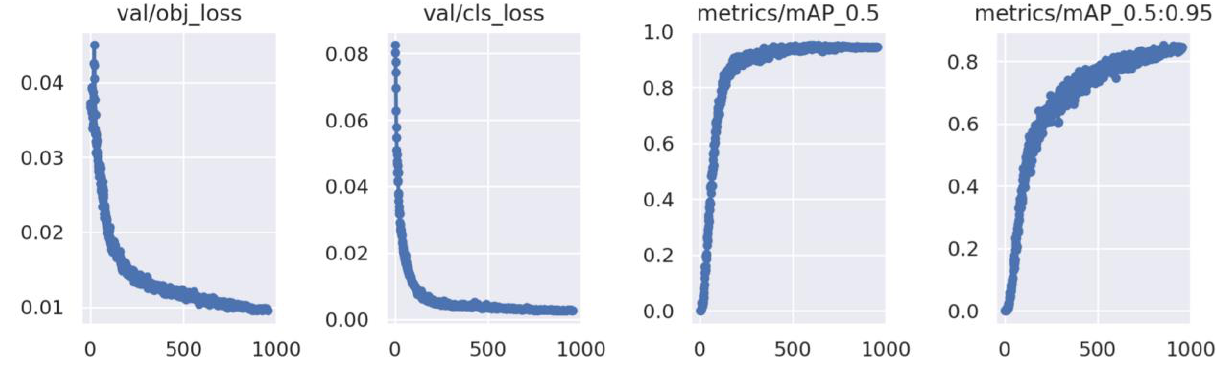
Figure 17. Loss curves with mAP.